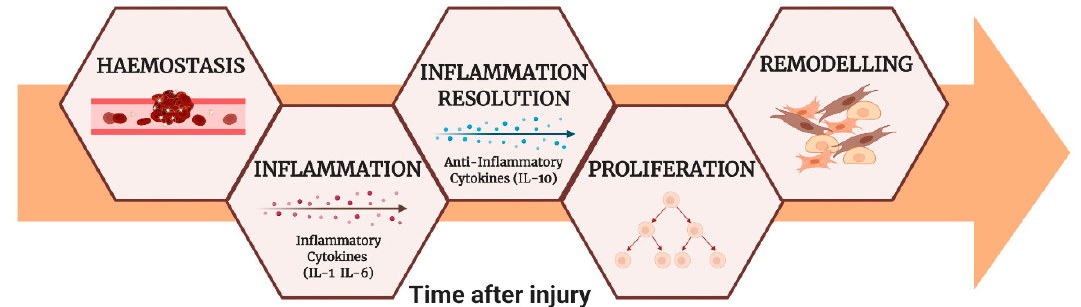
Figure 1. The wound-healing phases.